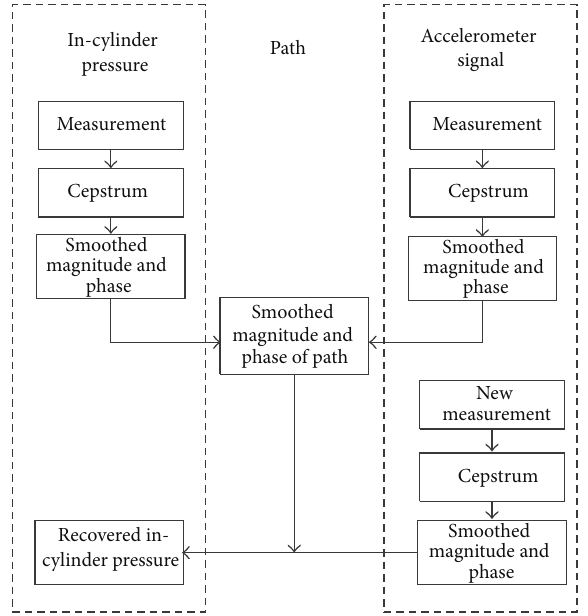
Figure 1: In-cylinder pressure estimation based on the cepstral smoothing